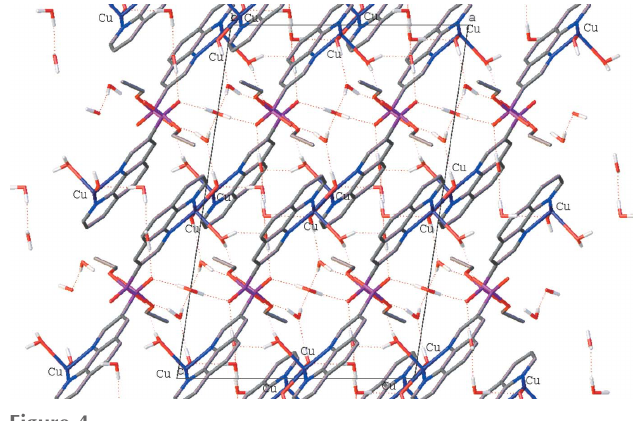
Figure 4 View of the hydrogen-bonded network along the b axis.